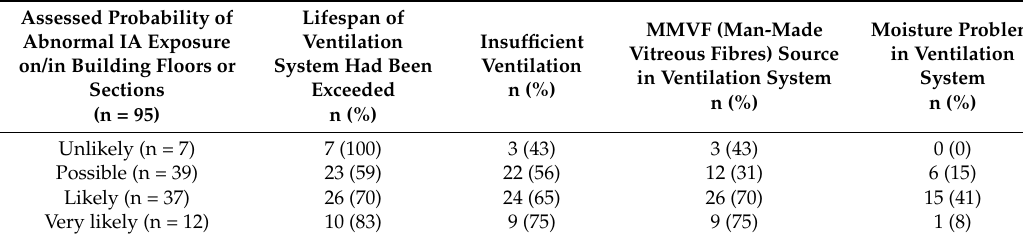
Table 2. Ventilation survey findings are included in all the sections or floors in which probability of abnormal IA exposure was assessed (95 floors or sections). (All building floors or sections (111) were investigated and we were able to assess the probability of abnormal IA exposure on or in 95 building floors or sections.).